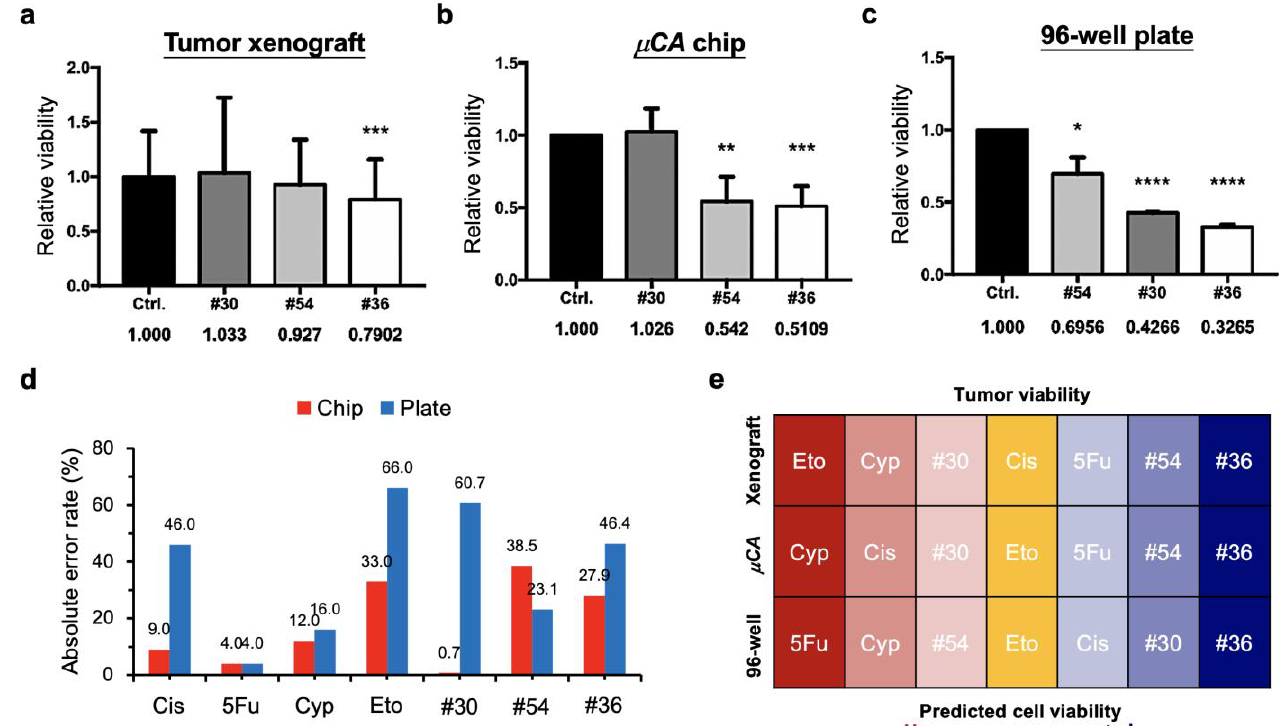
Figure 6. Efficacy of the optimal drug combinations inhibiting MCF-7 cells and tumors cultured in different models: ( a ) The zebrafish tumor xenograft model. ( b ) The µCA chip model. ( c ) The 96-well plate model. ( d ) Comparison of the absolute error rates derived from the µCA chip and the 96-well plate. The values are defined as the different rates of cell viability compared to those derived from xenografts. ( e ) Comparison of the tumor-inhibiting yield derived from xenograft, µCA chip, and 96- well plate. Drug combinations (#30, #36, and #54) and the corresponding single drugs used can be seen in Figure 5b. Results show that the in vitro drug efficacy (17.9% error rate and 57.1% prediction rate) derived from the µCA chip partially simulates the in vivo zebrafish results, compared to 96- well plate model (37.5% error rate and 28.6% prediction rate). Control groups are denoted as Ctrl. Numbers of zebrafish used for each test can be seen in Figure 5b. * p < 0.05, ** p < 0.01, *** p < 0.001, and **** p < 0.0001.